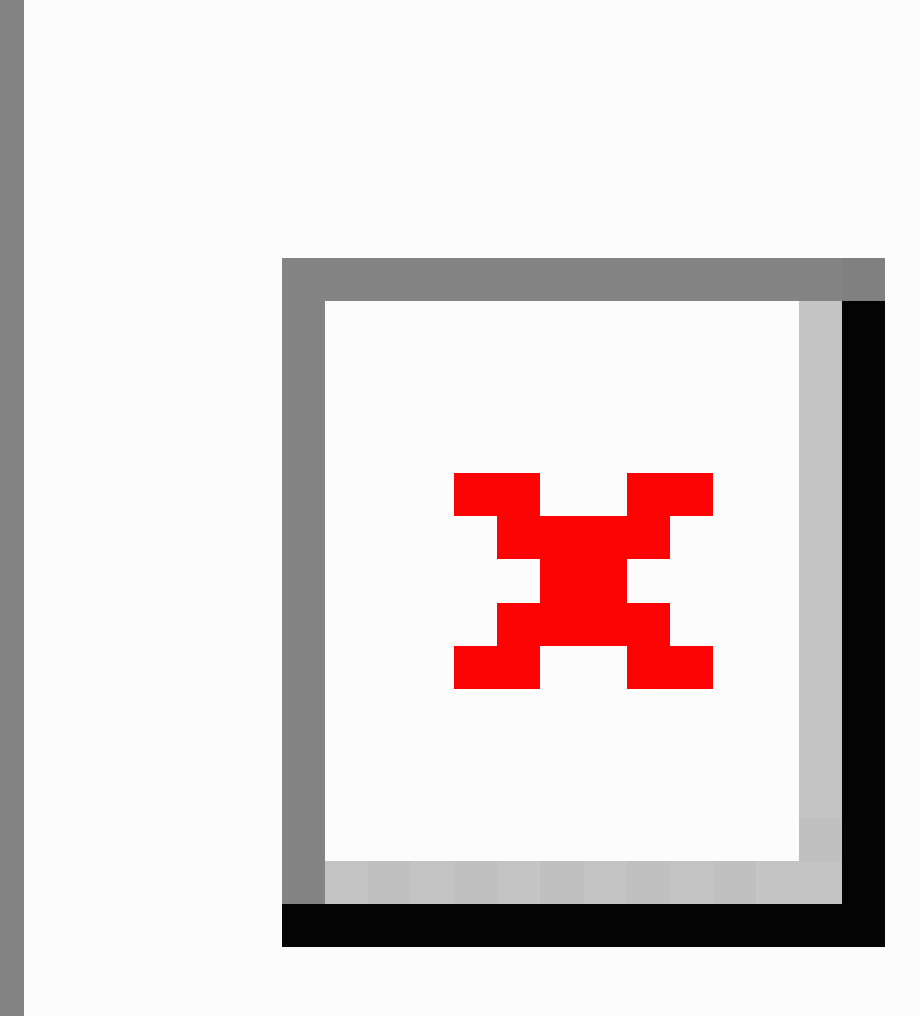
Figure 1. Screenshot of